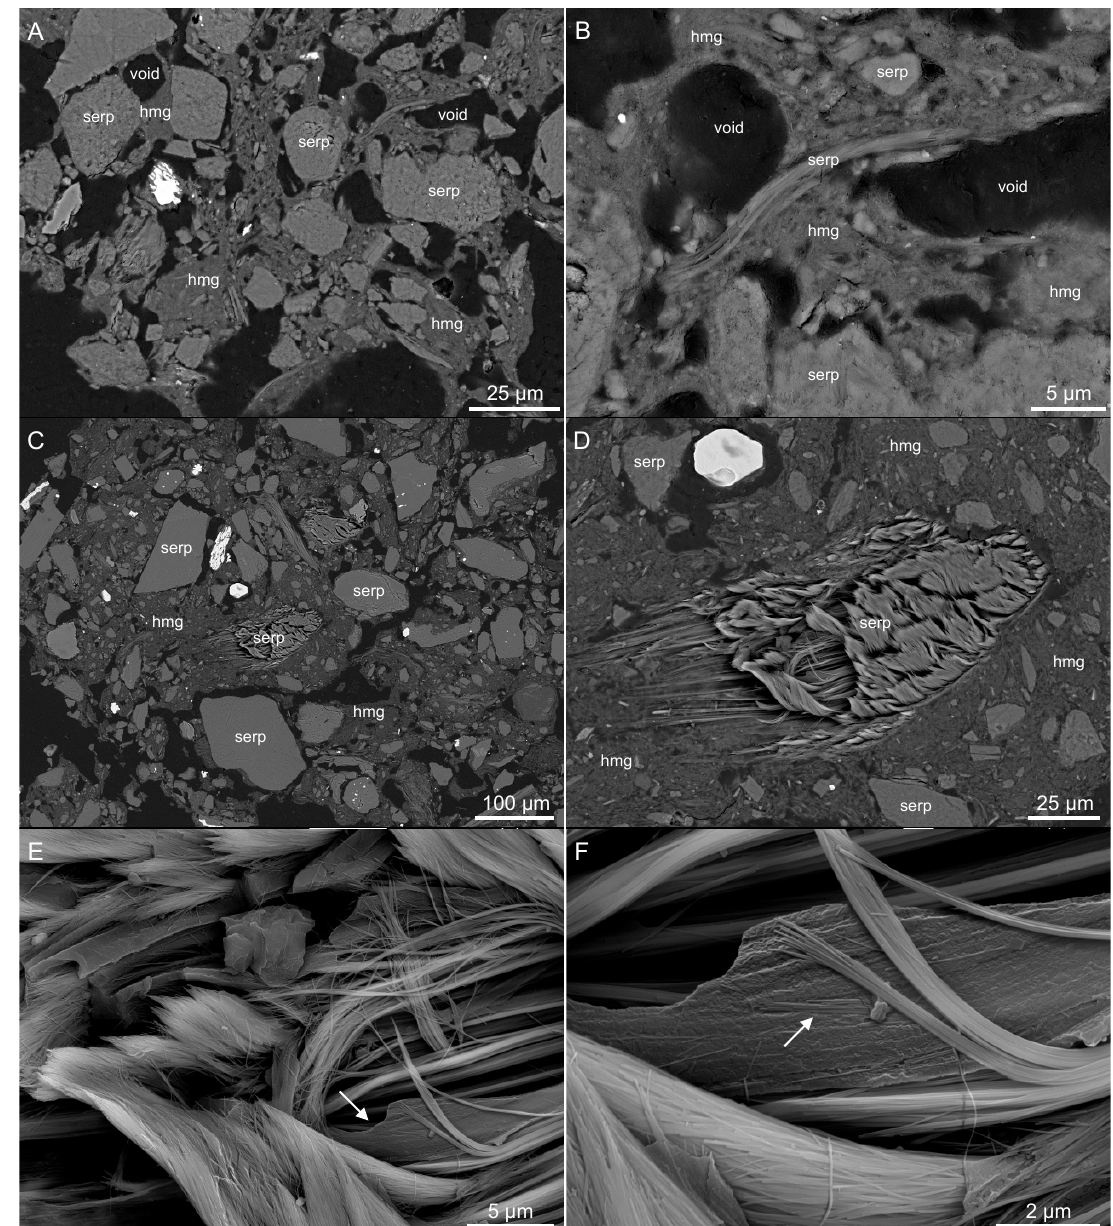
Figure 3. Electron micrographs of a cross-section through the carbonate horizon (2–4 cm depth) in the Bio-plot. ( A ) The hydromagnesite initially formed as meniscus cements at grain contacts. ( B ) Cements can be observed immobilizing bundles of chrysotile fibers. ( C ) In some cases, voids are in-filled with hydromagnesite cement. ( D ) The hydromagnesite cement has immobilized serpentinite grains. ( E ) Cement beginning to form among fibers of chrysotile (arrow). ( F ) Chrysotile fibers (arrow) enclosed in cement forming within a serpentinite grain. Note, hmg: hydromagnesite, serp: serpentinite.